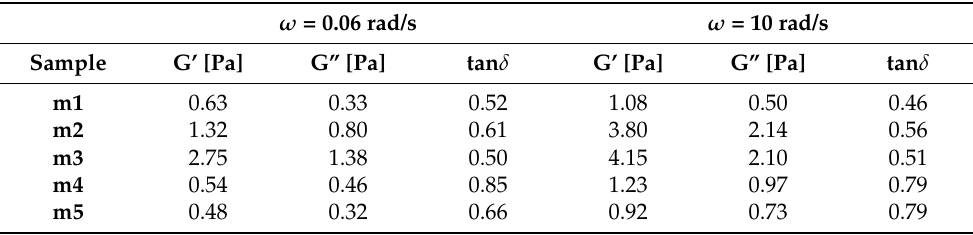
Figure 5. ( a , b ): Measurement results of oscillatory shear rheology (OSR). Four of the five investigated mucus samples revealed gel characteristics (m1, m2, m3, m5). One sample revealed close moduli (m4). The abbreviations in the brackets give detailed information about the demographic data of the patients belonging to the samples: 1. digit: gender (f: female, m: male); 1. digit: larynx status (h: healthy, p: pathologic); 3. digit: smoking behavior (s: smoker, f: former smoker, n: non-smokers); 4/5. digit: age. Table 4. Storage (G’), loss (G”) moduli and tan δ of the mucus samples investigated by OSR at the evaluation limits of ω = 0.06 rad/s and ω = 10